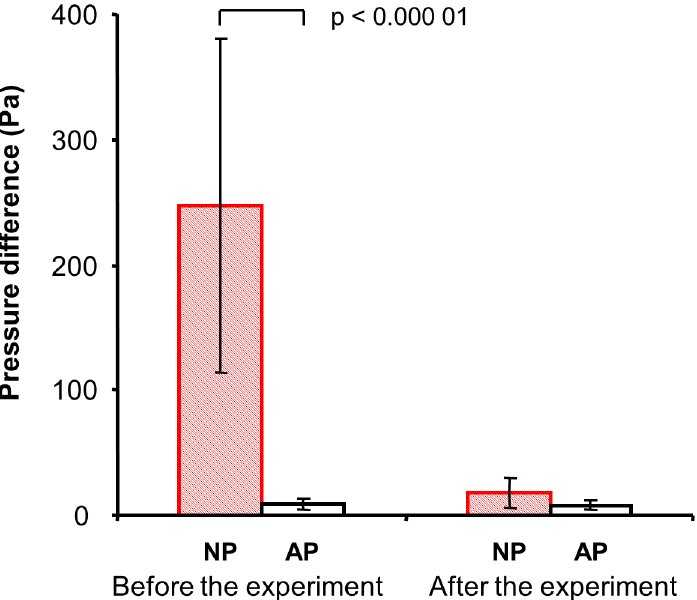
Fig 8. Airflow resistance of snow to breathing expressed as an overpressure in the breathing circuit developed at a constant flow rate of 60 L/min for no air pocket (NP) and one liter air pocket (AP) before and after completing the breathing